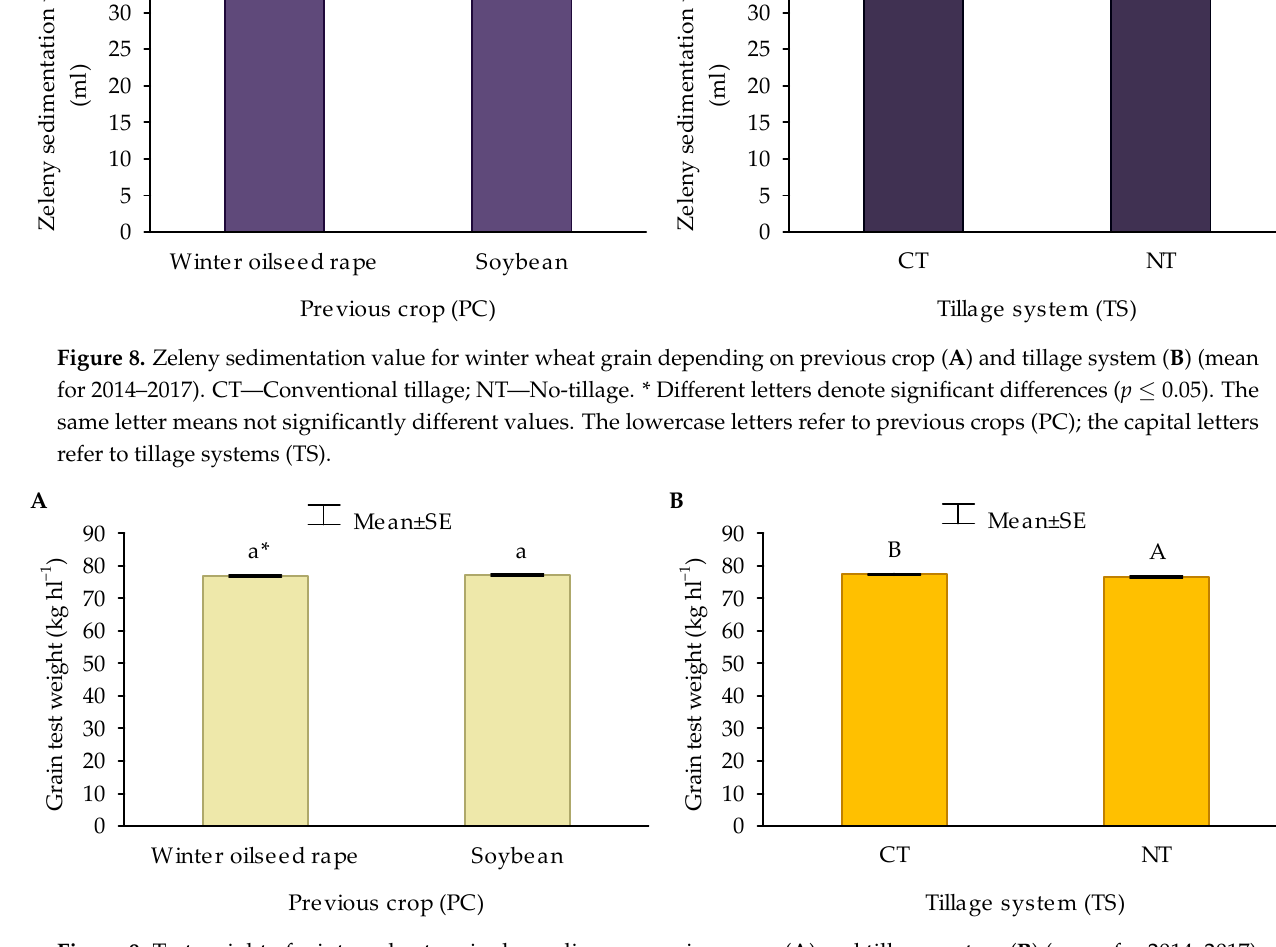
CT—Conventional tillage; NT—No-tillage. * Different letters denote significant differences ( p ≤ 0.05). The same letter